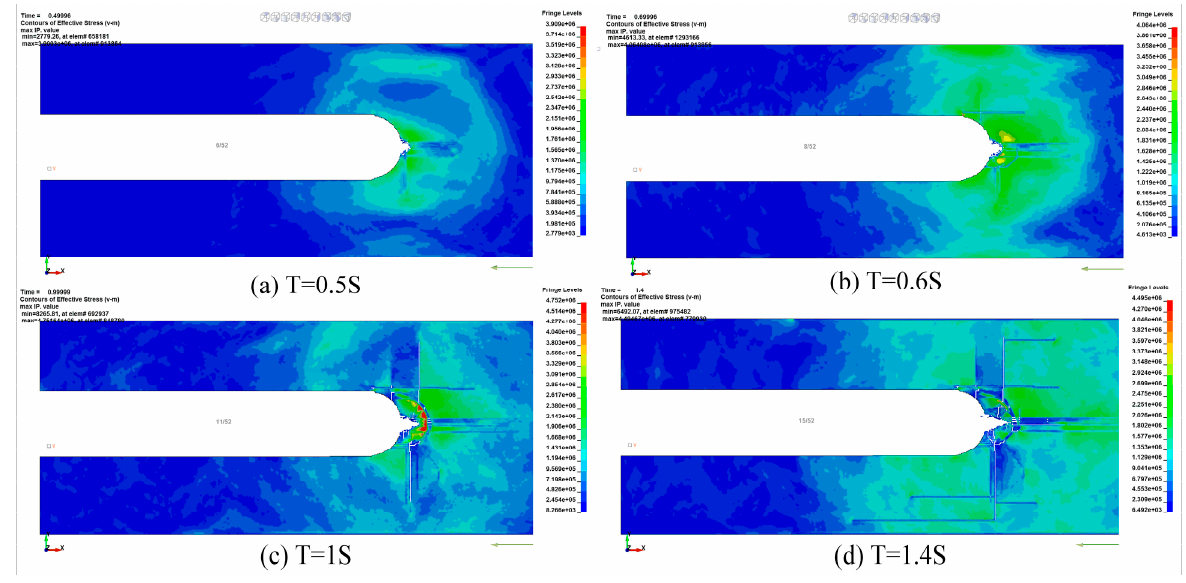
Figure 12. Icebreaking in peak interval Ⅰ .